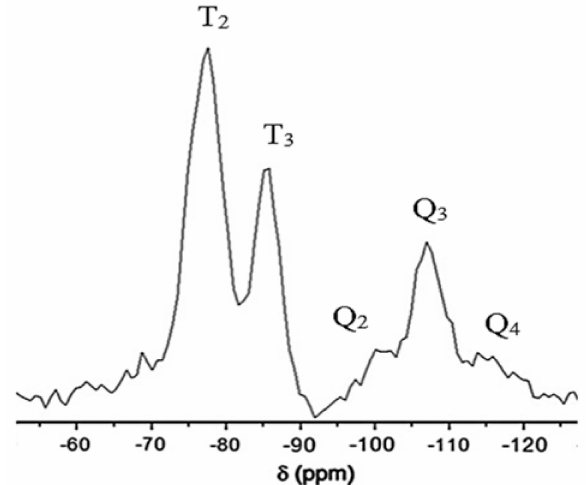
Figure 1. 29 Si-NMR spectrum of the material obtained by condensation of a trialkylalkoxysilane with